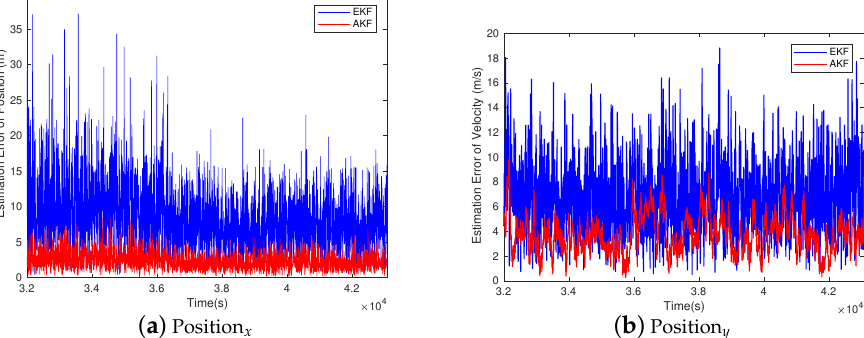
Figure 8. The figure reflects estimation error of position and velocity by EKF and AKF in period between 32,000 s and 43,080